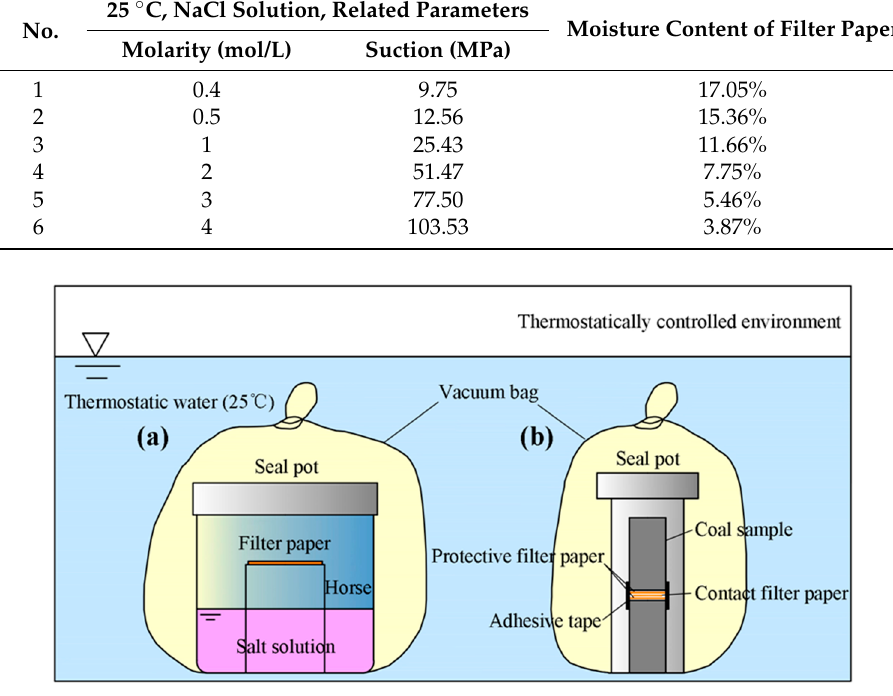
Figure 3. ( a ) Sketch of suction calibration test; ( b ) Illustration of filter paper test.